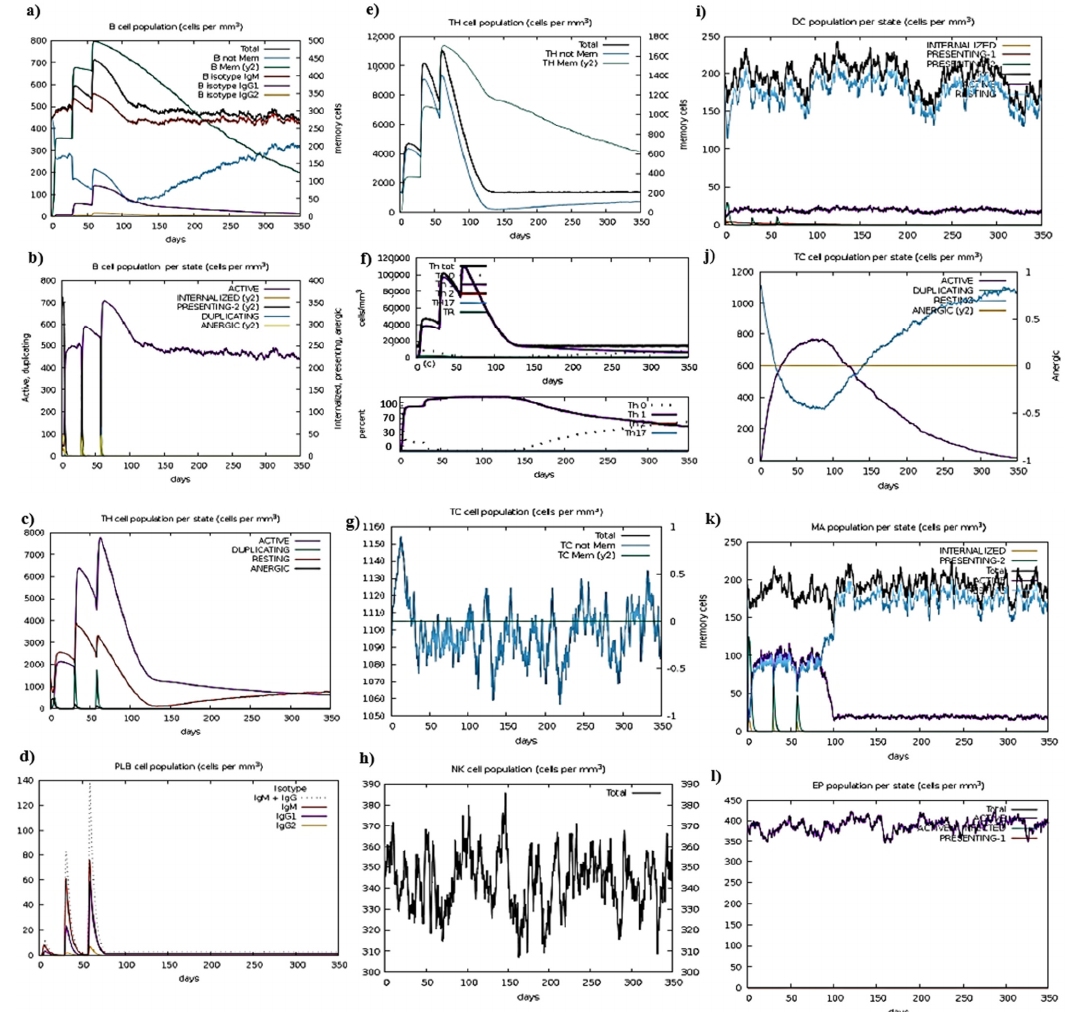
Figure 5. Representation of simulation; ( a ) After an antigen injection, the B cell population grows; ( b ) B cell population per state; ( c ) T helper cell population per state; ( d ) Immunoglobulin or antibody production after antigen injection; ( e ) T helper cell population after antigen injection; ( f ) T helper cell population in a cell in mass cell ratio with its percentage coverage; ( g ) T cell population after antigen interaction; ( h ) Natural killer cells population after antigenic vaccine interaction; ( i ) The population of dendritic cells as per state; ( j ) Population coverage of T cell as per state; ( k ) Population coverage of MA as per state; ( l ) The population of eosinophils per state after antigen injection.